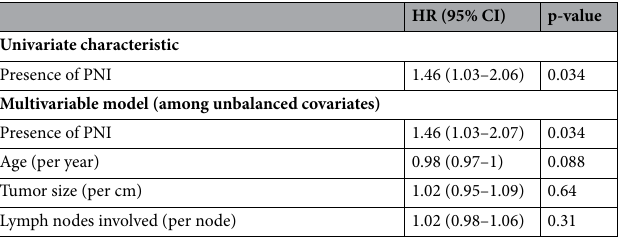
Table 5. Locoregional recurrence among those with PNI compared to a PNI-negative propensity-matched cohort.